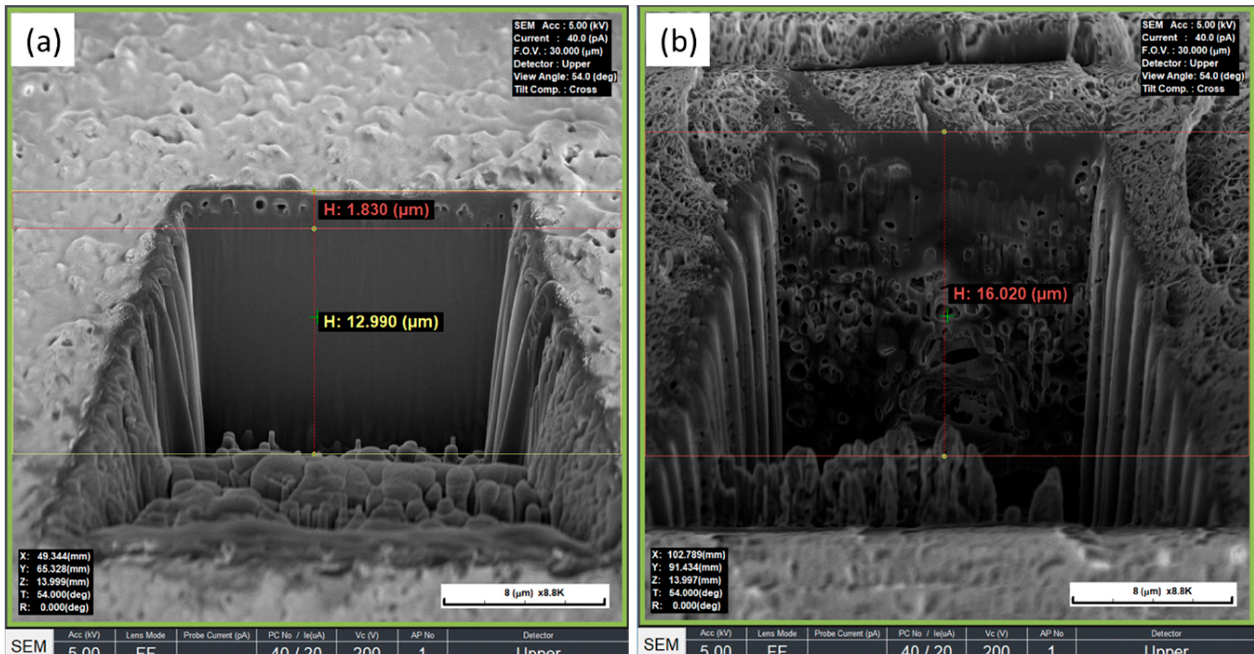
Figure 2. SEM images of PEEK implants treated with a mixed acid of sulfuric and nitric acid for 90 s under ultrasound and then washed with distilled water under mechanical agitation for 6 h.